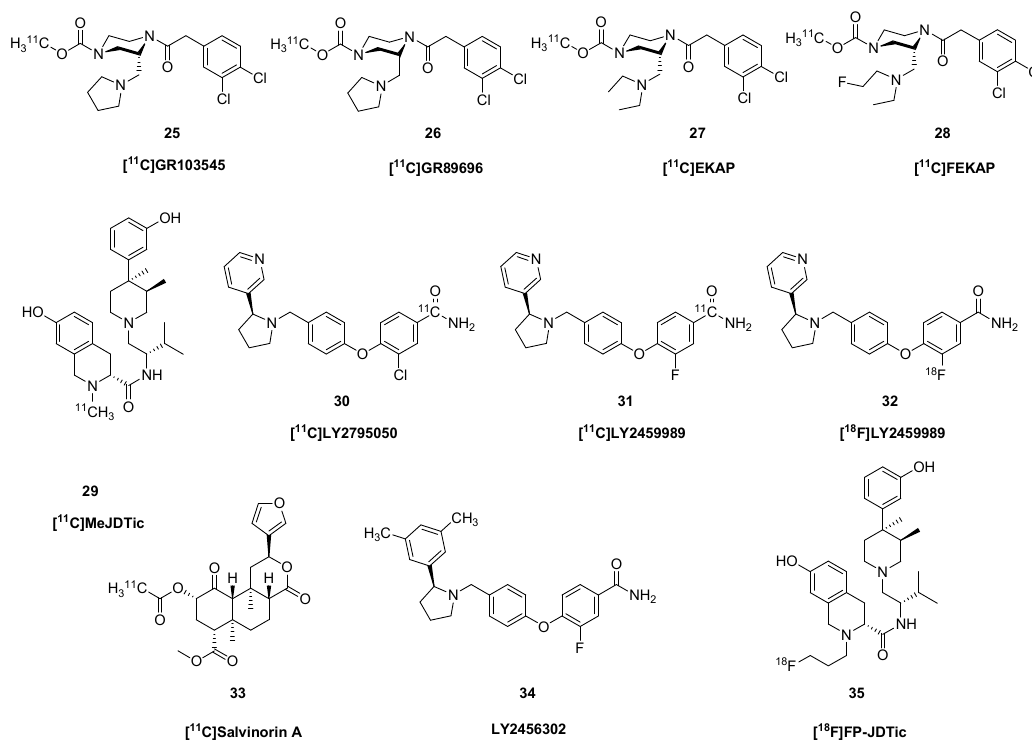
Figure 5. Selected κOR ligands.